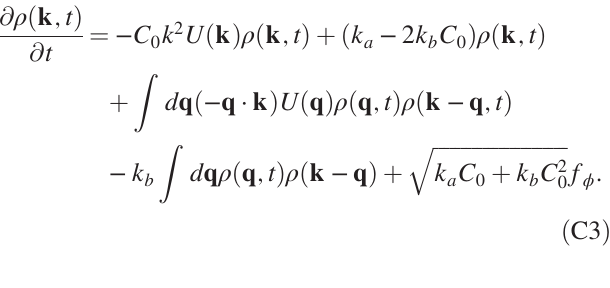
diagrammatic representation of the